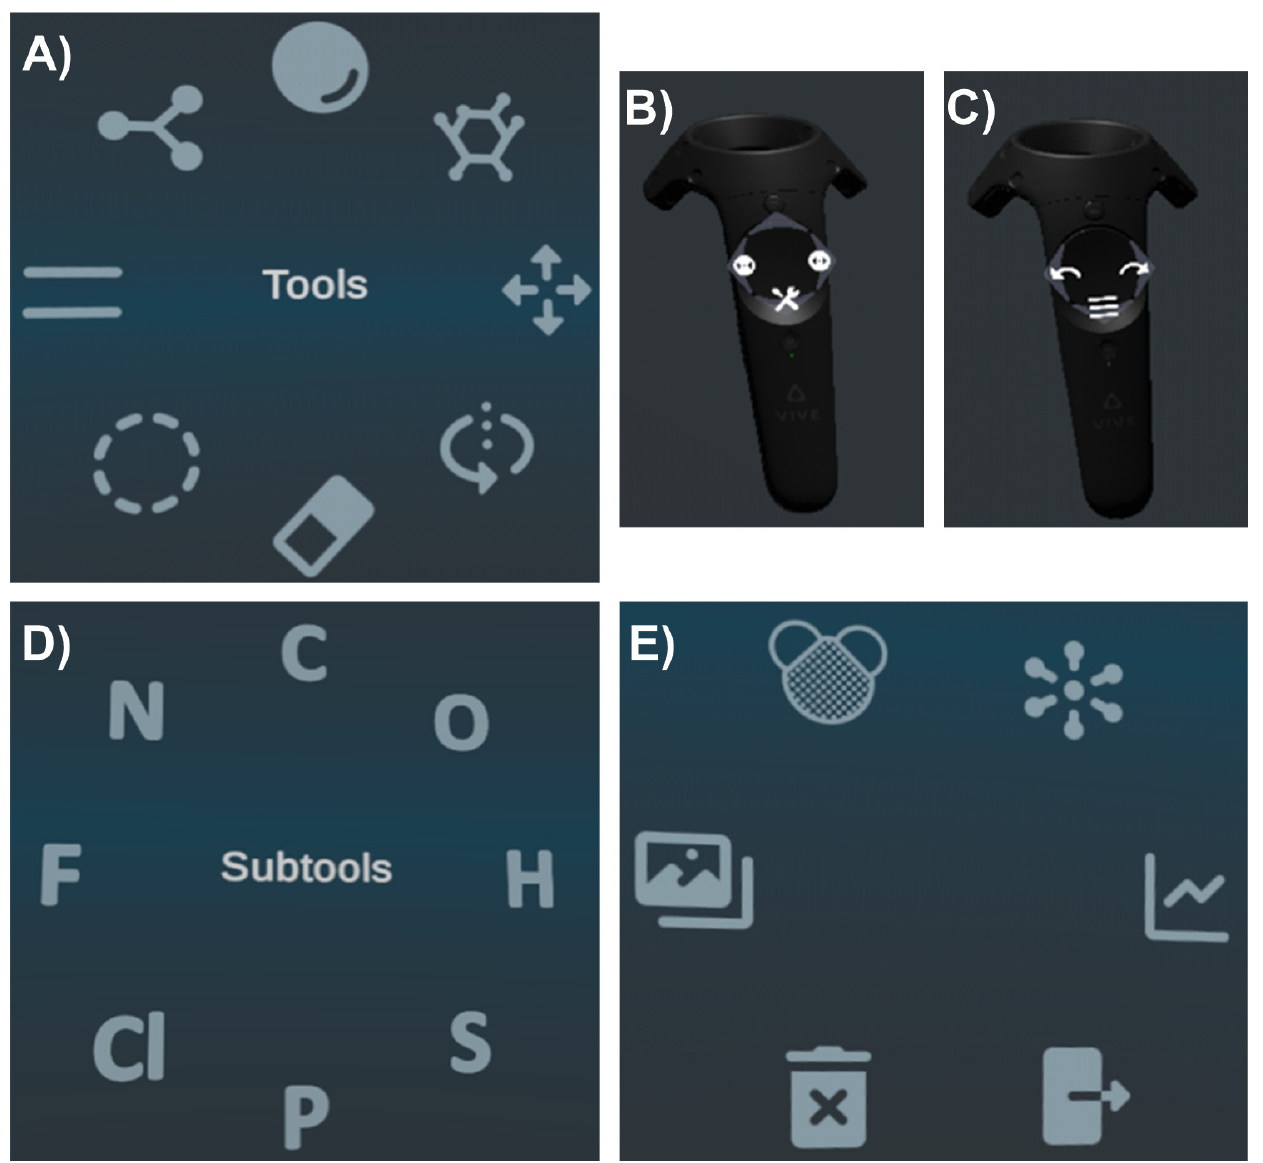
Figure 1. ( A ) the menu of the right controller; ( B ) the buttons of the right controller; ( C ) the menu of the subtools on the right controller; ( D ) the menu of the subtools on the right controller; ( E ) the menu of the subtools on the right controller.